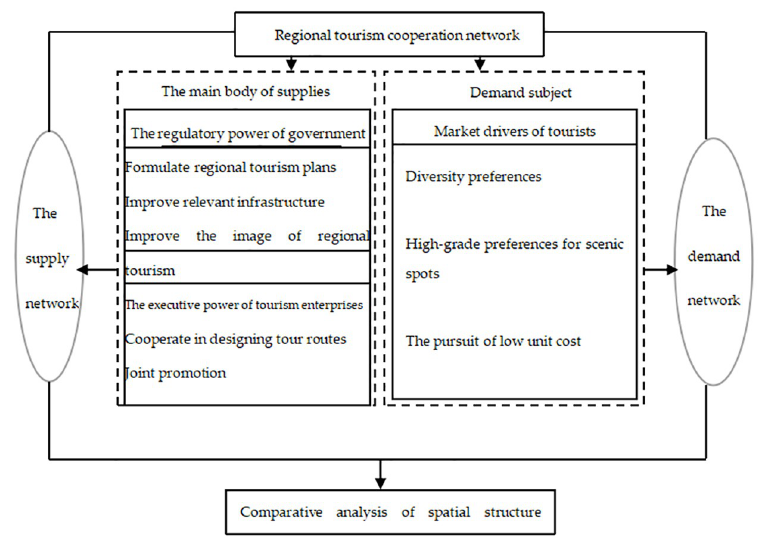
Fig 1. Analysis framework of a regional tourism cooperation